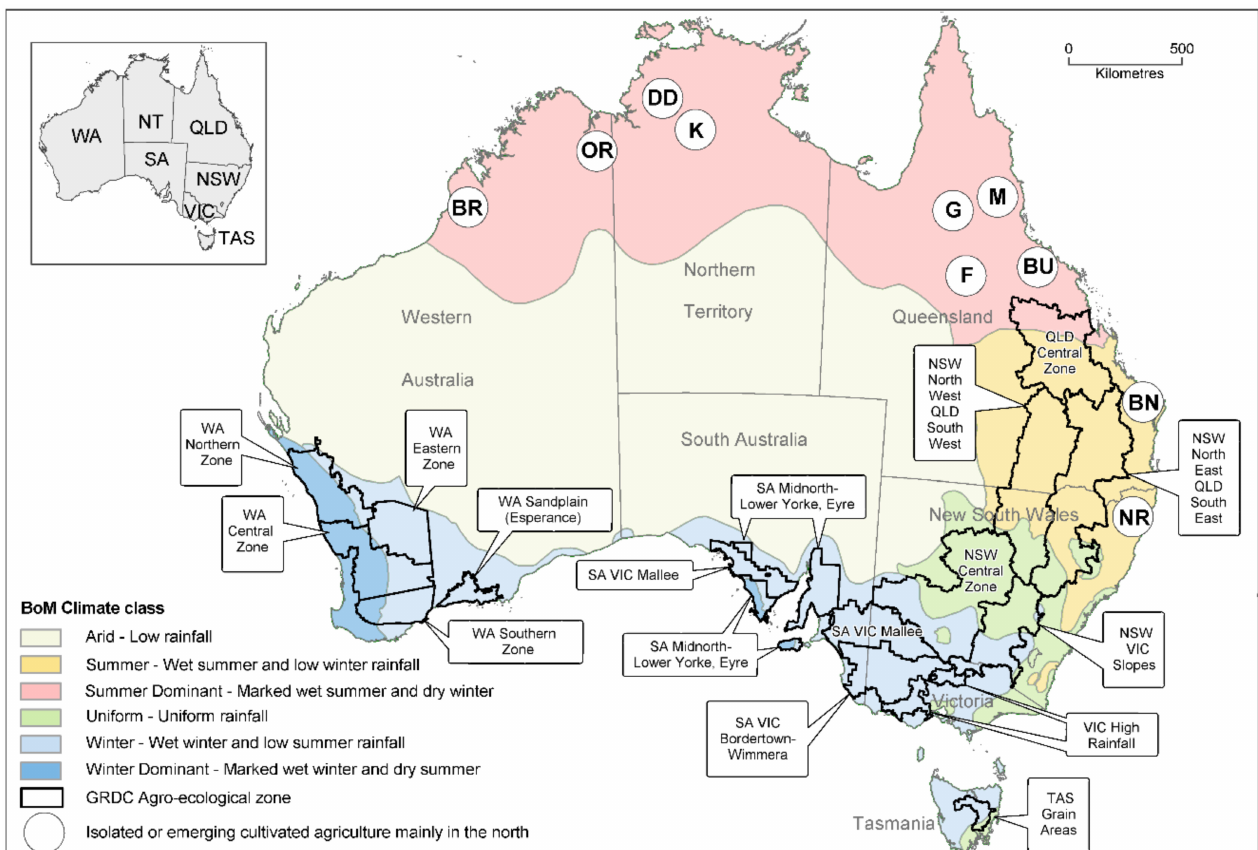
Figure 1. Map of the Australian continent. The state and territory acronyms shown are NSW (New South Wales), NT (Northern Territory), QLD (Queensland), SA (South Australia), TAS (Tasmania), VIC (Victoria) and WA (Western Australia). The map shows: (i) the principal regions where grain crops are grown differentiated by Australian Bureau of Meteorology (BOM) climate classes, and (ii) smaller isolated regions of irrigated grain production designated by letters: Broome (BR) and the Ord River Irrigation Area (OR) in WA; Douglas/Daly (DD) and Katherine (K) regions in the NT; Burdekin (BU), Bundaberg (BN), Gilbert (G), Flinders (F), Mareeba (including Atherton and Ravenshoe) and (M) regions in QLD; and Northern Rivers (NR) region in NSW. The agro-ecological zones bounded black lines constitute a modified version of those delineated by the Australian Grains Research and Development Corporation (GRDC) [51]. Image credit @Department of Primary Industries and Regional Development/P.